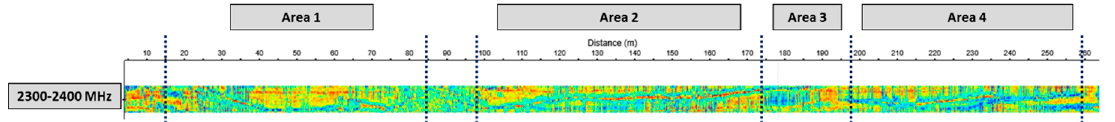
Figure 9. High frequency effects.